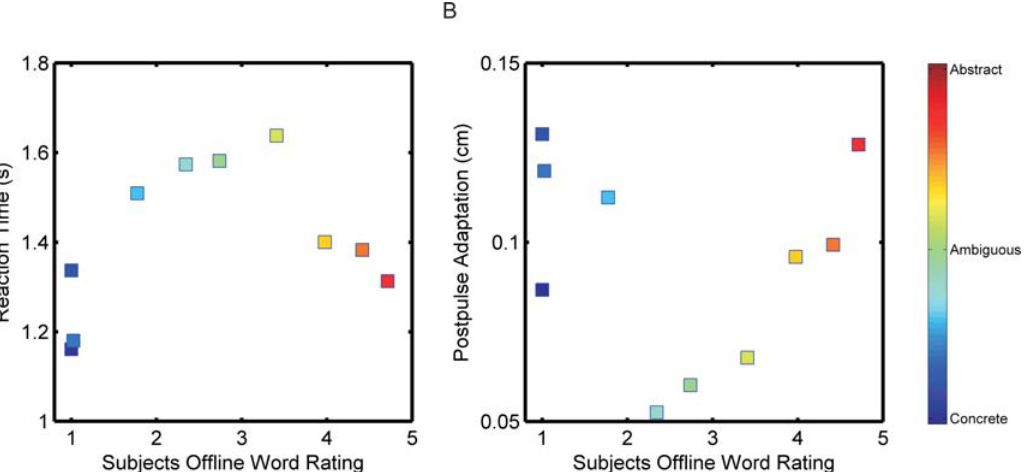
Figure 3. The dependence of categorization speed and adaptation on subjects’ semantic conception of words. Offline, subjects categorized words presented during the movement task on a scale of 1 to 5, with 1 being most concrete, and 5 being most abstract. Ratings were separated into 10 equally sized bins and averaged across subjects. Colorbar (side) represents the linear spectrum of subjects’ offline word survey of concreteness from most concrete (blue) to most abstract (red). A) Online word categorization RT was the fastest for words that were best categorized into concrete or abstract words offline. Subjects were slowest for ambiguous words, which were words that subjects classified as not falling directly into concrete or abstract categories during the offline survey. B) Subjects adapted the most to words that fell best into concrete or abstract categories, while words that were ambiguous had the least adaptation.